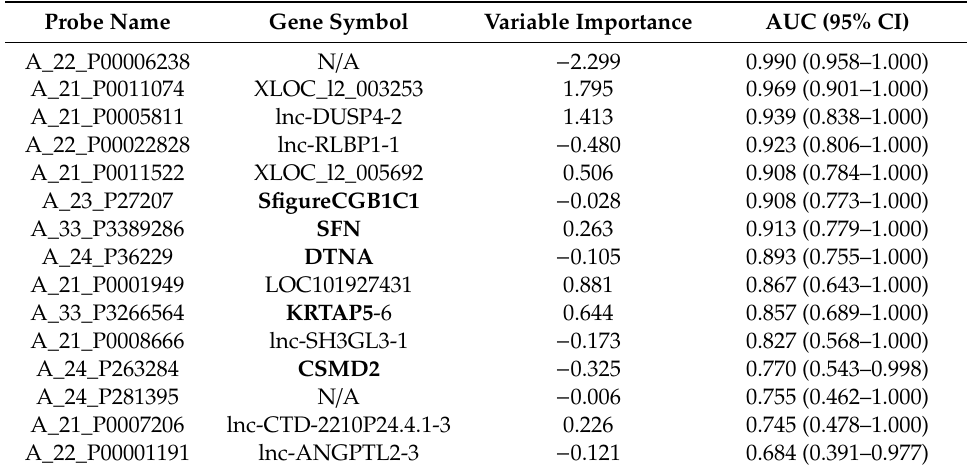
Figure 3. Variable importance coefficients derived from least absolute shrinkage and selection operator (LASSO) penalized logistic regression used to identify DE transcript predictive of the diagnosis of NCWS. Table 3. Area under the receiver operating characteristic (ROC) curve of the most relevant transcripts selected by LASSO regression model.